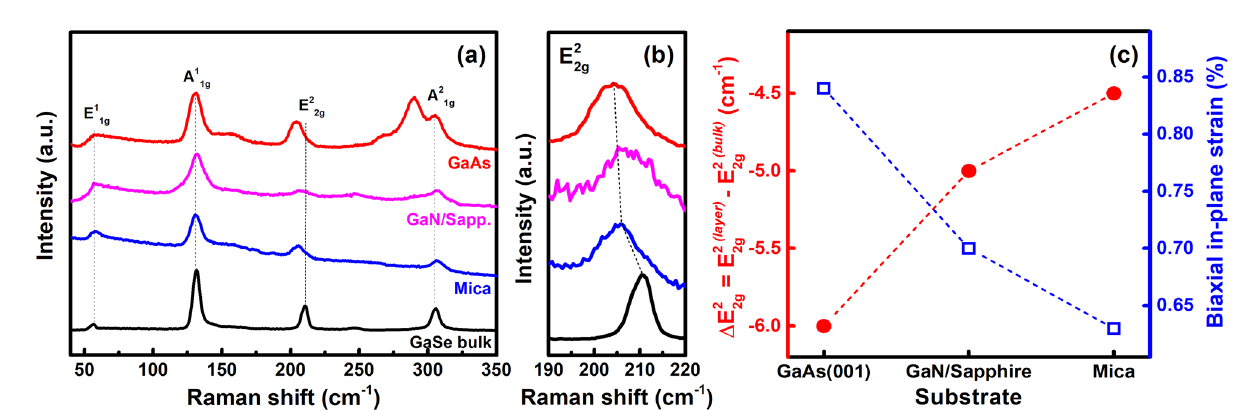
Figure 5. ( a ) Raman scattering spectra of GaSe bulk and GaSe films grown on various substrates, ( b ) An enlarged Raman spectra near E 2 2g peaks, and ( c ) Biaxial in-plane lattice strain of these GaSe layers extracted 2 from the red-shift of E 2 g Raman active